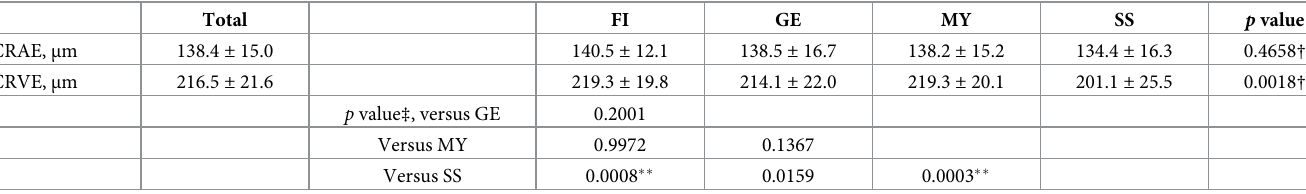
Table 2. Comparison of retinal vessel calibers among different optic disc appearances.